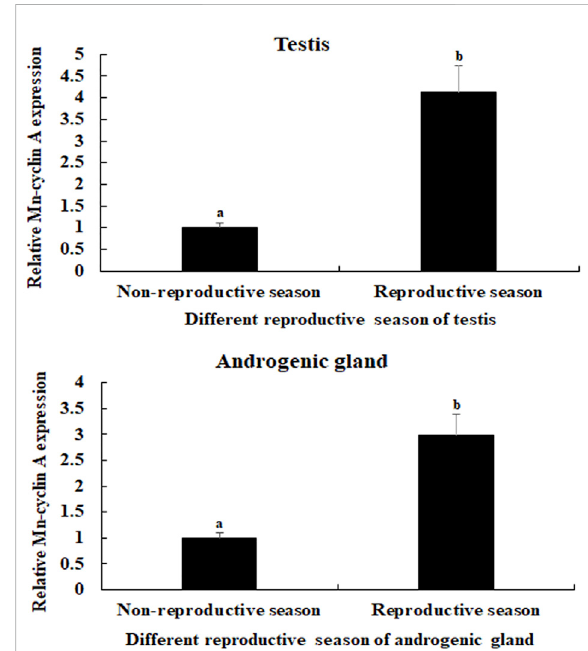
FIGURE 2 Measurement of the Mn - CycA expression in the testis and androgenic gland taken from different reproductive season. The amount of Mn-CycA mRNA was normalized to the EIF transcript level. Data are shown as mean ± SD (standard deviation) of tissues from three separate individuals. Lowercases indicate expression difference between different samples. (A) Mn-CycA expression in the testes taken from different reproductive season. (B) Mn-CycA expression in the androgenic gland taken from different reproductive